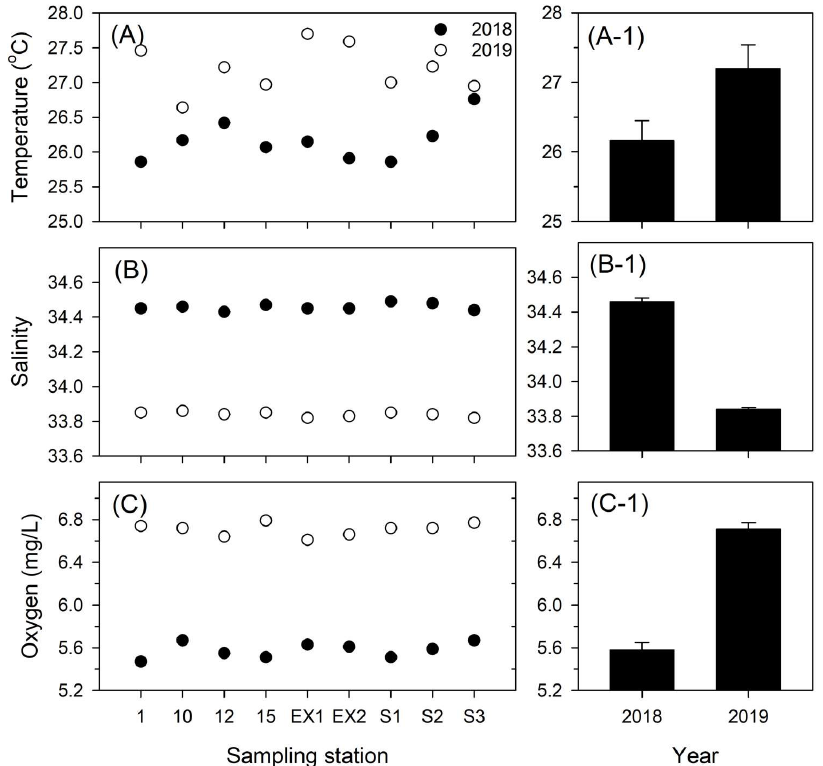
Figure 2. Variation of seawater temperature ( A ); salinity ( B ); and dissolved oxygen ( C ); as well as comparisons of the seawater temperature ( A-1 ); salinity ( B-1 ); and dissolved oxygen ( C-1 ) in aver- age values (mean ± standard deviation) from the cruises in June 2018 and June 2019.